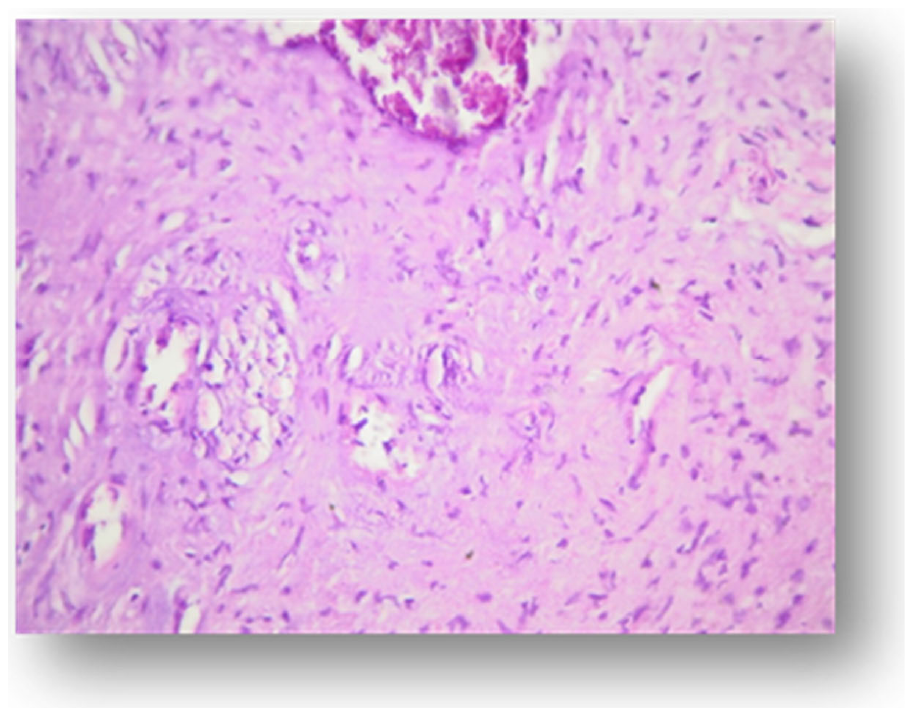
Figure 3. Coronal dental pulp aspect of a 47 year old female, type 2 diabetes HE staining, ×200.